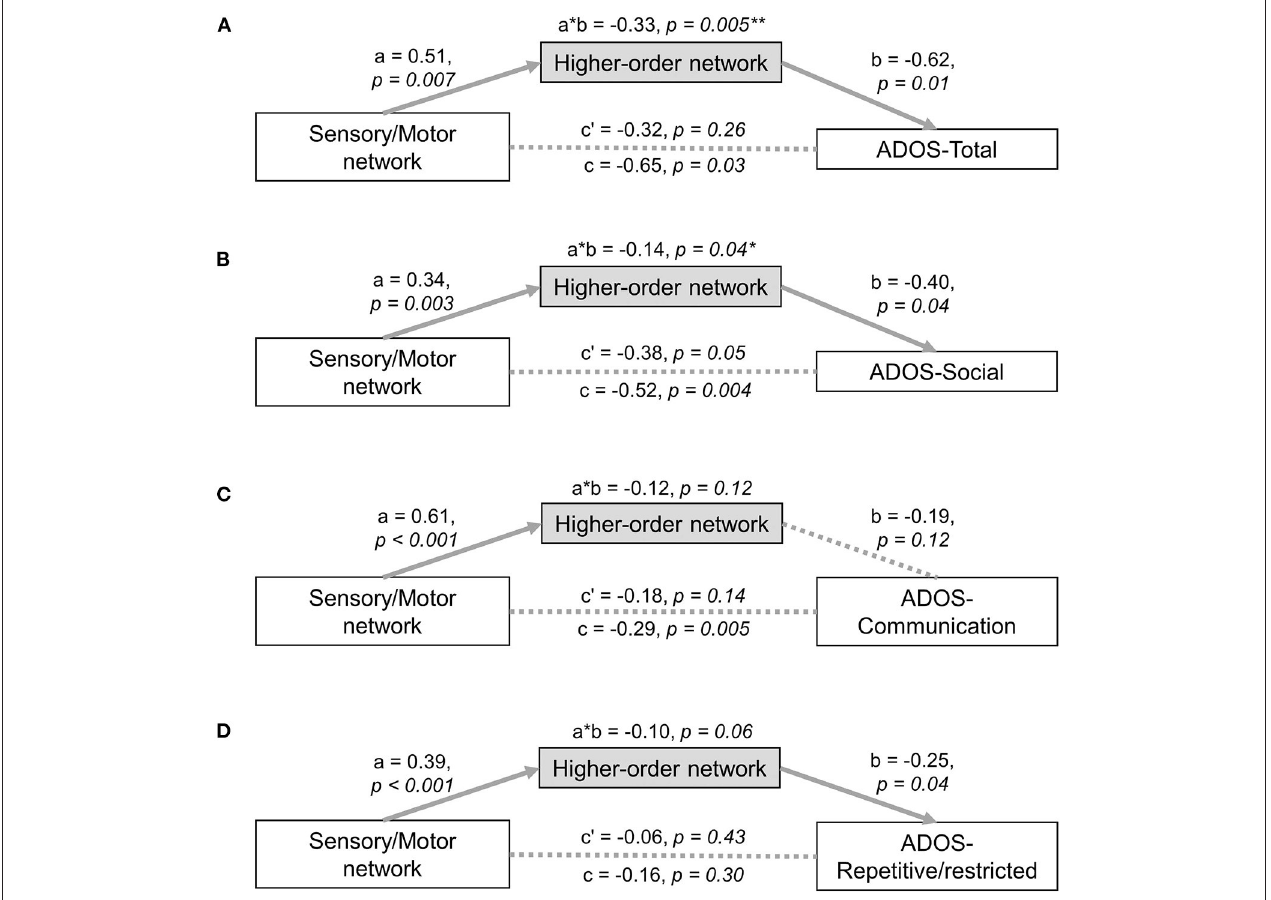
FIGURE 5 | Mediation analysis. Mediation analyses with low-level sensory network as the predictor and high-order network as the mediator were tested with the following ASD symptom severity as a responder: (A) ADOS-total score, (B) ADOS-social score, (C) ADOS-communication score, (D) ADOS-repetitive/restricted behavior score. * significant at p < 0.05, ** survived multiple comparison correction using a false discovery rate procedure, ADOS, Autism Diagnostic Observation